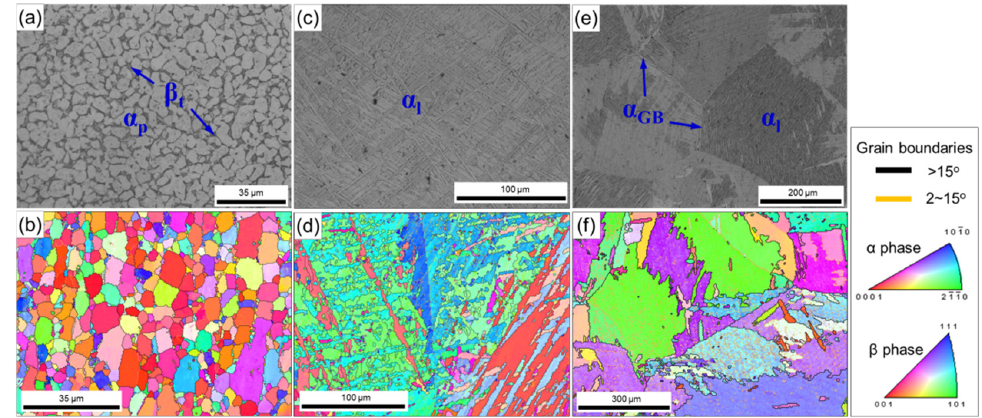
Figure 1. Initial microstructures of Ti-6Al-4V alloy: ( a , b ) equiaxed microstructure, ( c , d ) basket-weave microstructure and ( e , f ) widmannstatten microstructure.